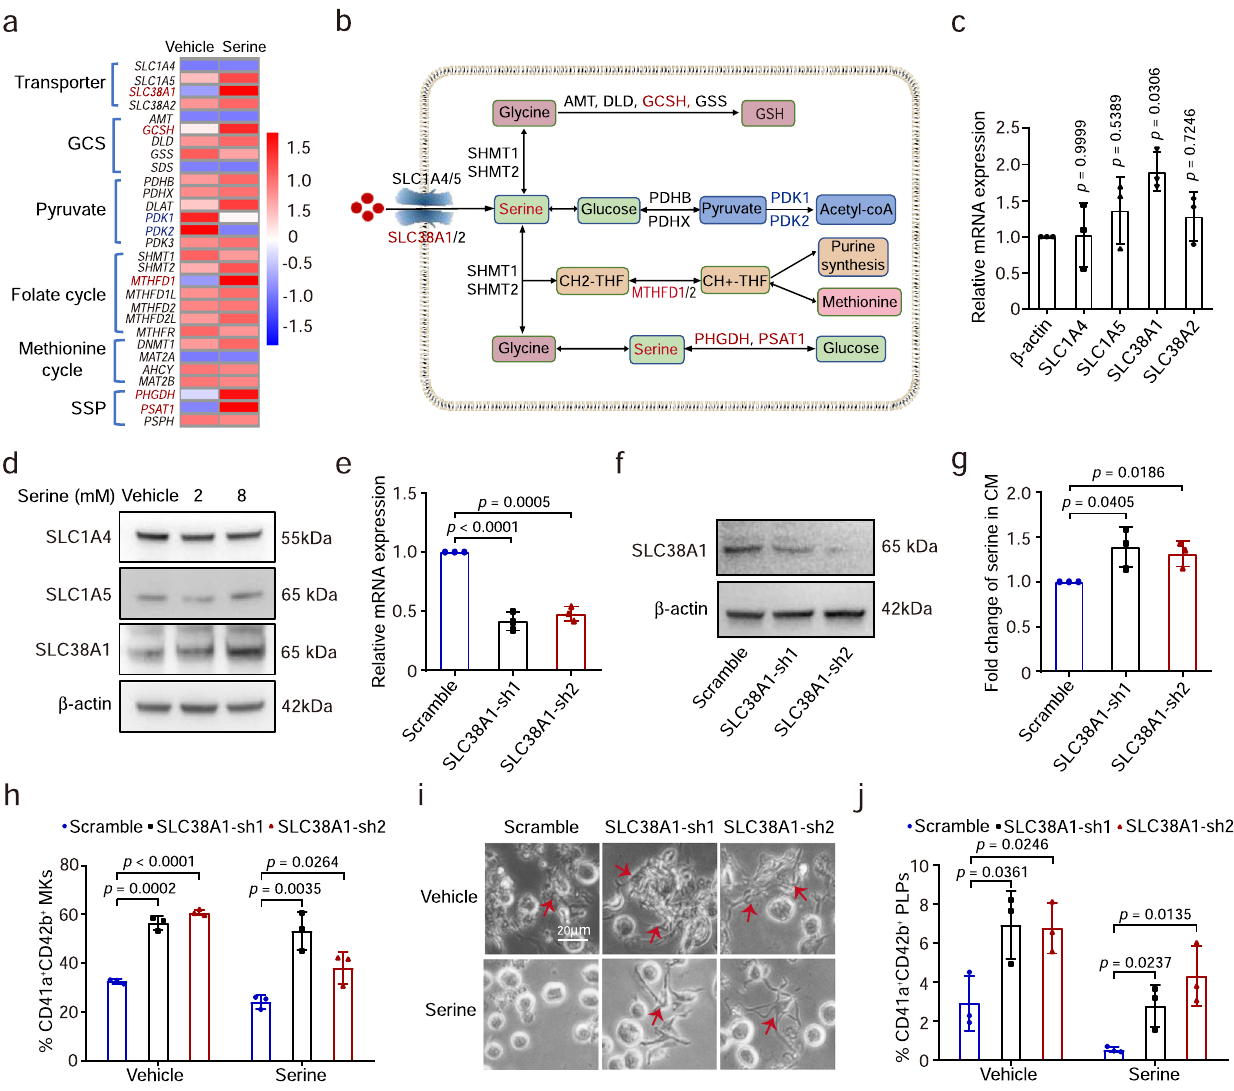
Fig.4|SerineuptakeismediatedbySLC38A1.a The expression pro fi le of serine metabolism-related genes in MKs cultured with vehicle or excessive serine. b Schematics of serine metabolism. c Assessment of mRNA expression of serine transporters in differentiated cells treated with vehicle or excessive serine at day 12(mean±SD, n =3independentexperiments).Signi fi cancewasanalyzedwithan One-way ANOVAfollowedbyDunnett ’ smultiplecomparisontest. d Protein levels of SLC1A4, SLC1A5 and SLC38A1 were detected with immunoblotting in differ- entiated cells treated with vehicle or serine at day 12. n =3 independent experi- ments. e The mRNA levels of SLC38A1 in CD34 + cells containing control and SLC38A1 shRNAs as detected with qPCR analysis (mean±SD, n =3 independent experiments). f Protein levels of SLC38A1 were detected with immunoblotting in CD34 + cells infected with lentivirus-containing scramble or SLC38A1-shRNA. n =3